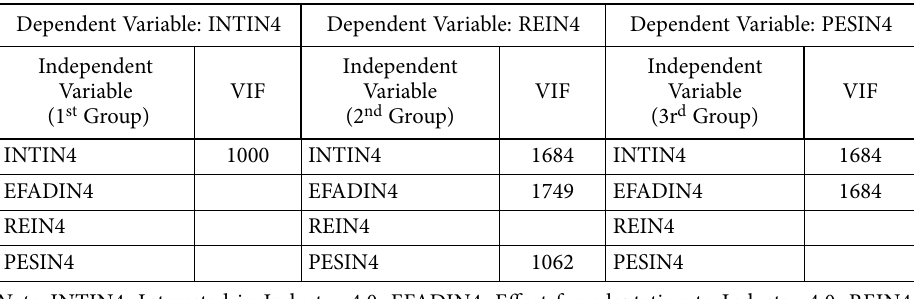
Table 11. Collinearity analysis results